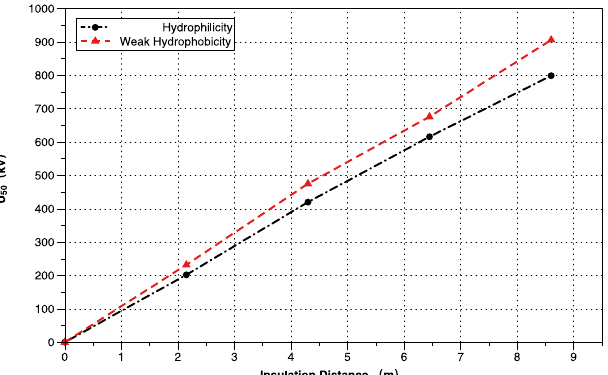
Figure 8. P ollution flashover test results of composite crossarm insulators with different insulation distance.